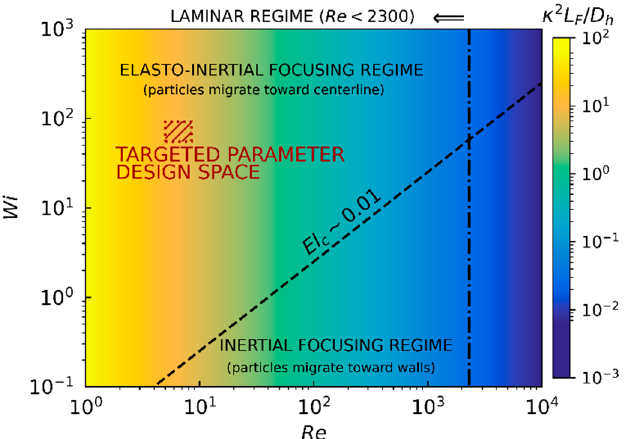
Figure 4. Regime diagram of the dimensionless Reynolds ( Re ) and Weissenberg ( Wi ) numbers for viscoelastic fluids of inertial flows in microfluidic channels. The colormap corresponds to the squared blockage ratio ( κ ) multiplied by the slenderness ratio ( L F / D h ); a value of C SG = 0.05 has been utilized. The diagonal dashed line (critical elasticity number El c ∼ 0.01) separates elasto-inertial from inertial focusing regimes, while the vertical dot-dashed line separates laminar ( Re < 2300) from transitional/turbulent flow regimes. The red dashed rectangle indicates the parameter design space targeted for sensing bacteria using microwave-based